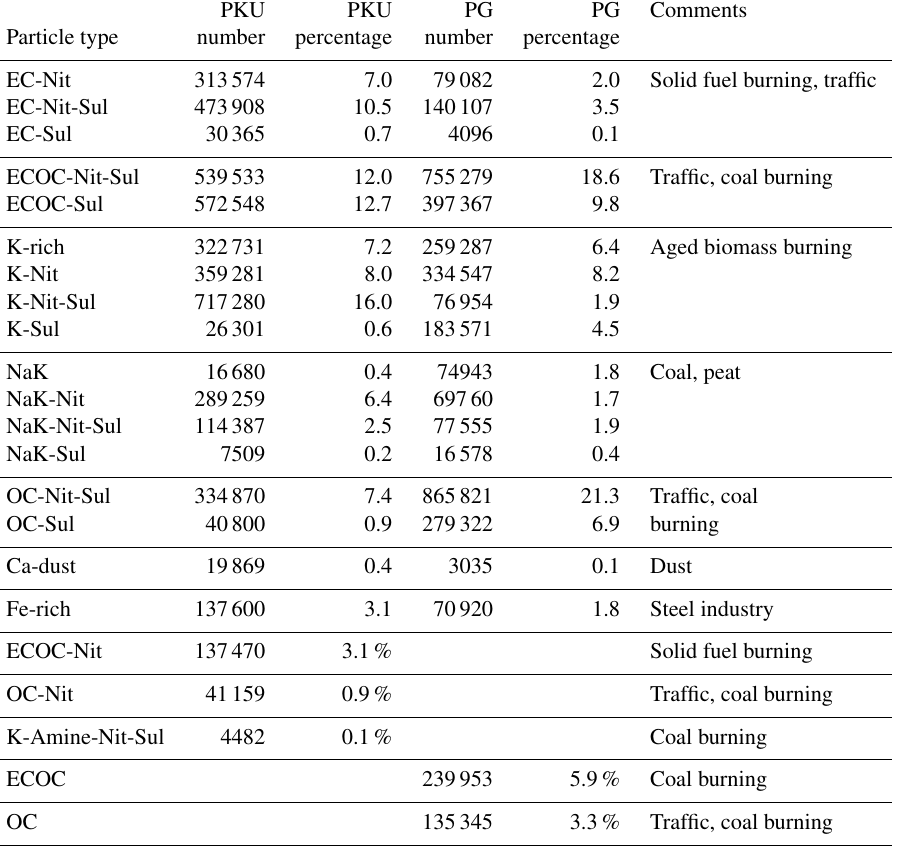
Note: Nit stands for nitrate and Sul for sulfate.